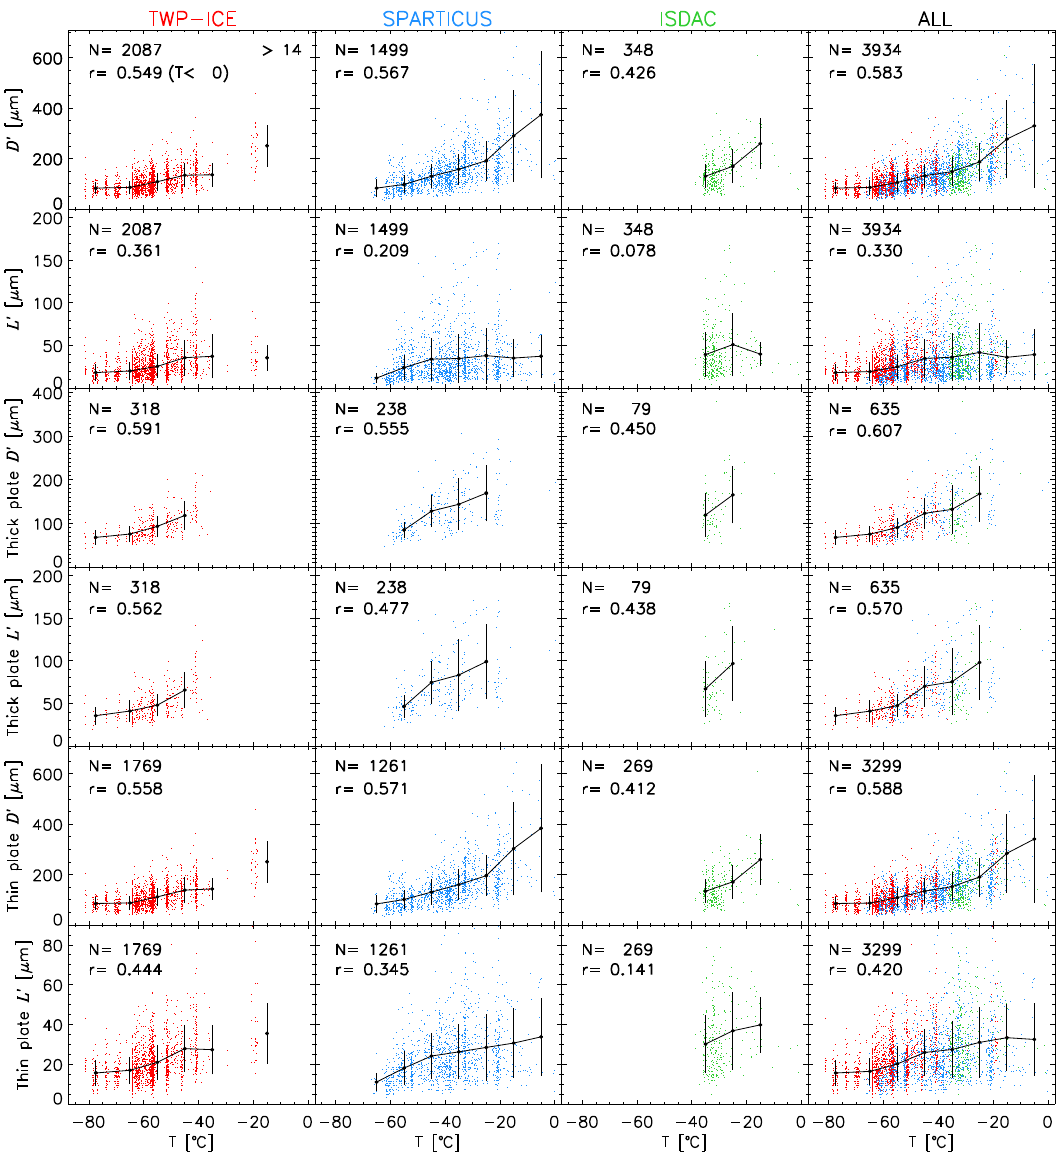
Figure 7. Measured D (cid:48) and L (cid:48) of all plates (top two rows), thick plates (middle two rows), and thin plates (bottom two rows) as a function of temperature. Correlation coefficient ( r ) for − 85 < T < 0 ◦ C is embedded in each panel. Colors and temperature ranges used are the same as in Fig.